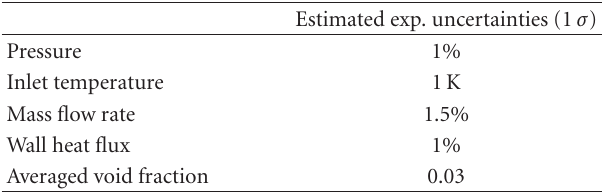
Table 2: Given experimental uncertainties on the controlling parameters of the test-case and on the void-fraction